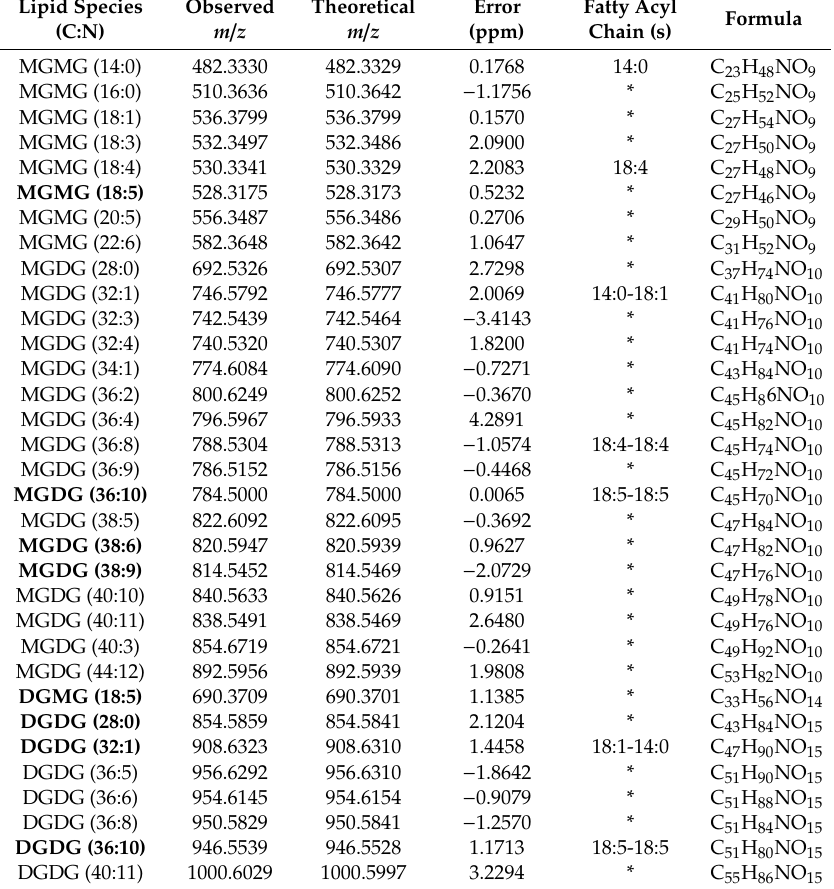
Table 3. Galactolipid species identified by liquid chromatography–mass spectrometry (LC–MS) in positive mode as [M + NH 4 ] + ions (error < 5 ppm). The identification as a galactoglycerolipids and fatty acyl composition was confirmed by analysis of tandem MS (LC–MS / MS) spectra of [M + NH 4 ] + ions. The numbers in parentheses (C:N) indicate the number of carbon atoms (C) and double bonds (N) in fatty acyl chains. The most abundant species of each class (relative abundance > 10%) are indicated in bold. Species identified only by retention time and mass accuracy are marked with an asterisk (*). MGMG, monogalactosylmonoacylglycerol; MGDG, monogalactosyldiacylglycerol; DGMG, digalactosylmonoacylglycerol; DGDG, digalactosyldiacylglycerol. Lipid Species Observed Theoretical Error Fatty Acyl m / z m / z (C:N) (ppm) Chain